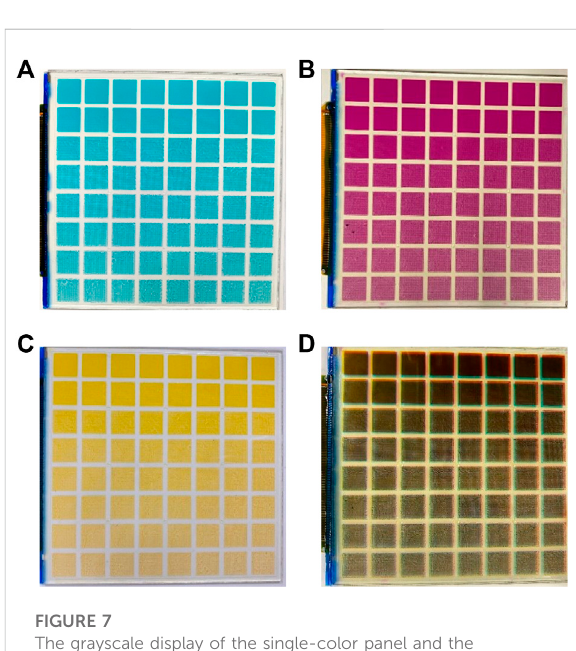
FIGURE 7 The grayscale display of the single-color panel and